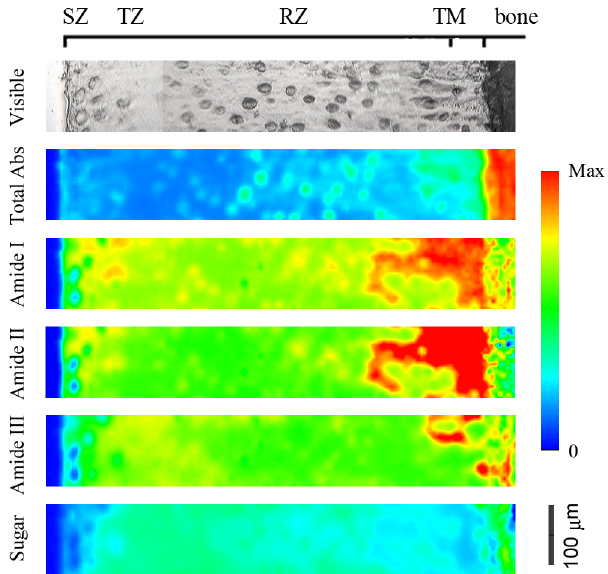
Fig. 3. A set of images of an typically induced osteoarthritic cartilage section from the top to the bottom, in turn visible image, total IR absorption image, amides I, II, III images, and 1072 cm (cid:1) 1 sugar image. The same color scale was used to plot the FT-IR images, with the max absorptions for the images from the top to the bottom being 1.45, 0.5, 0.35, 0.15, and 0.30, respectively. The black bar presents 100